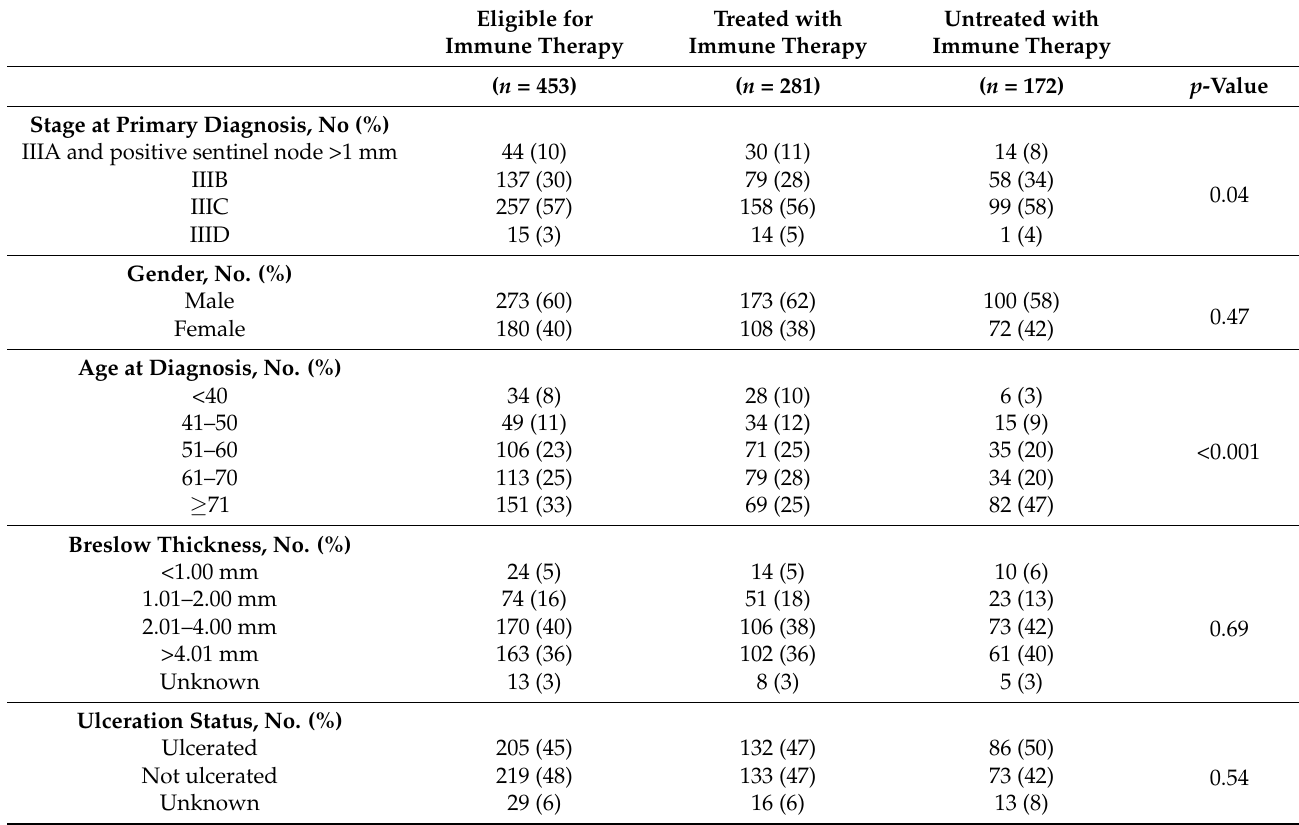
Table 3. Adjuvant systemic therapy received by patients diagnosed with a stage III primary melanoma who were eligible for adjuvant systemic therapy after January 2019.